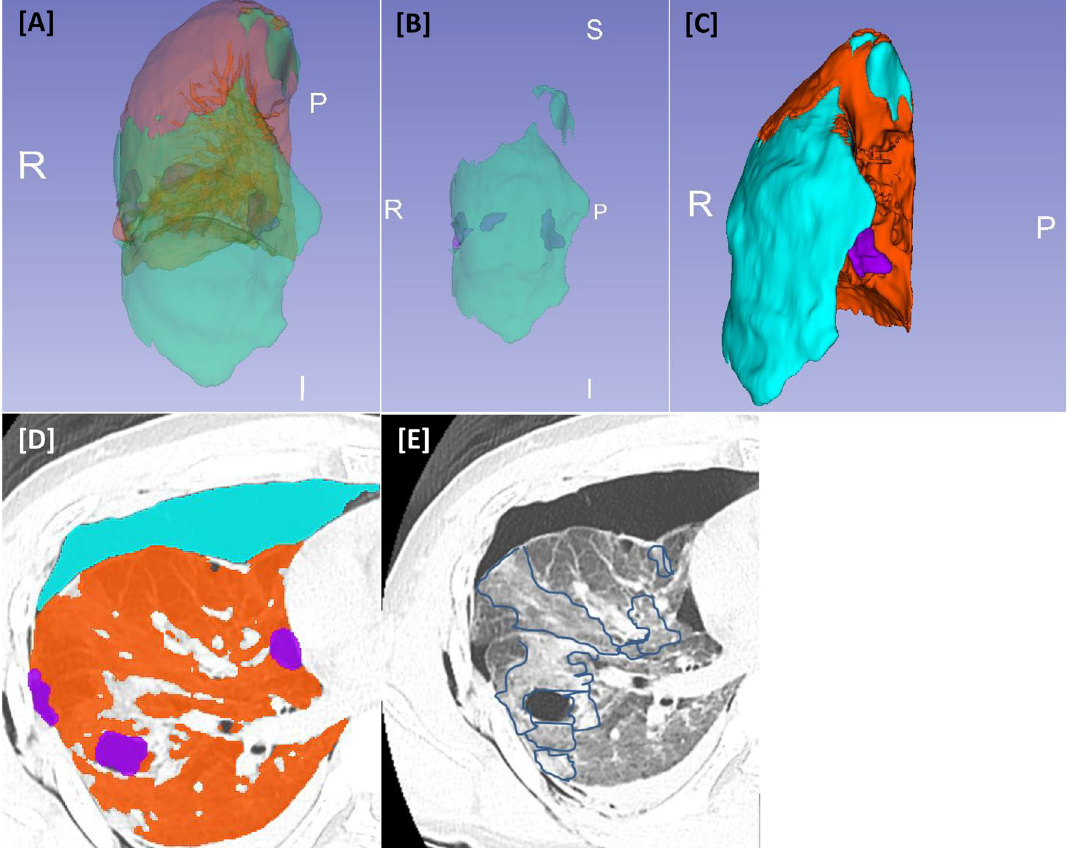
Figure 2. Process of lung segmentation with a three-dimensional (3D) slicer. The 3D model can be viewed after setting the most appropriate Hounsfield unit for lung segmentation. ( A ) anterior view, ( B ) parts excluding normal lung area, and ( C ) posterior view. Blue indicates the pneumothorax region, orange indicates the normal lung area, and purple indicates the segmented region with pulmonary contusion. ( D ) transverse view on chest computed tomography. ( E ) If there is an actual contusion and it is missing, it is indicated by hand labeling. R right, P posterior, I